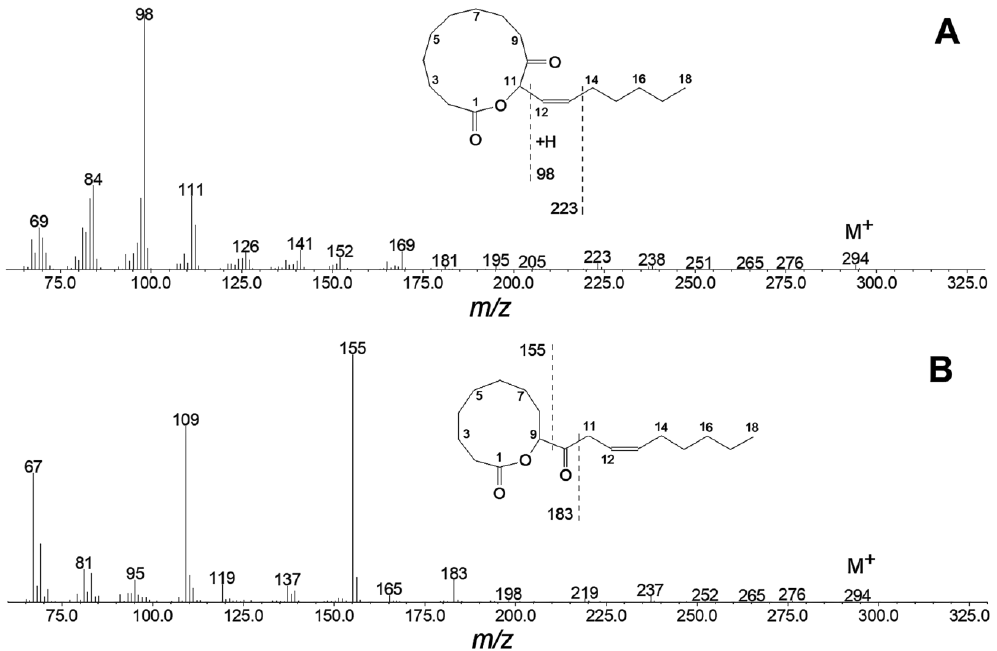
Figure 6. The electron impact mass spectra of products 11 ( A ) and 12 ( B ) formed when 9,10-EOD was kept for 2 h in hexane solution. Insets, the mass fragmentation schemes. The detailed experimental conditions are described in the Materials and Methods.